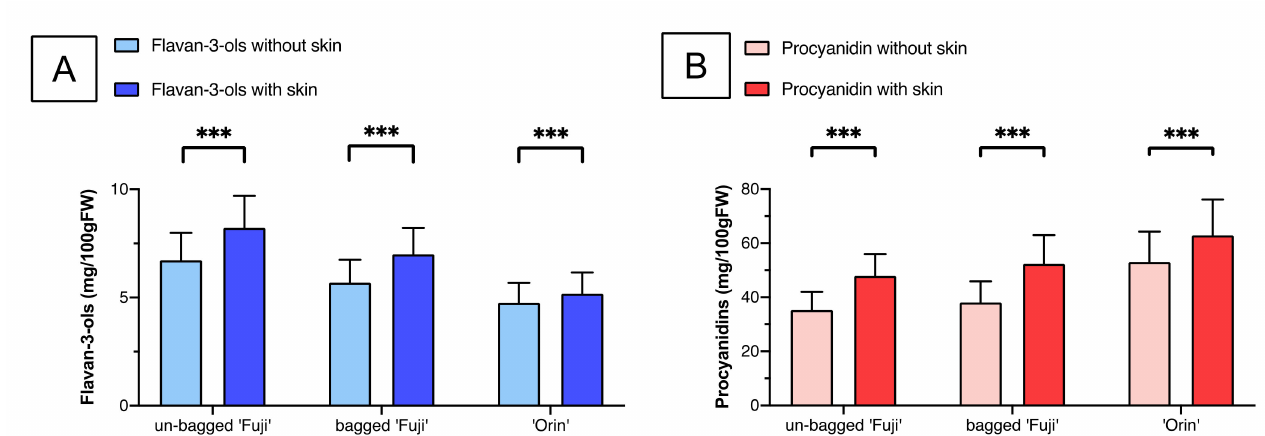
Figure 5. Comparison of the ( A ) flavan-3-ols and ( B ) procyanidins in the ‘Fuji’ and ‘Orin’ apples with and without the peel during the 2017 season. Data are shown as means ± deviation, where significant differences were evaluated using an unpaired two-tailed Student’s t -test (*** p <